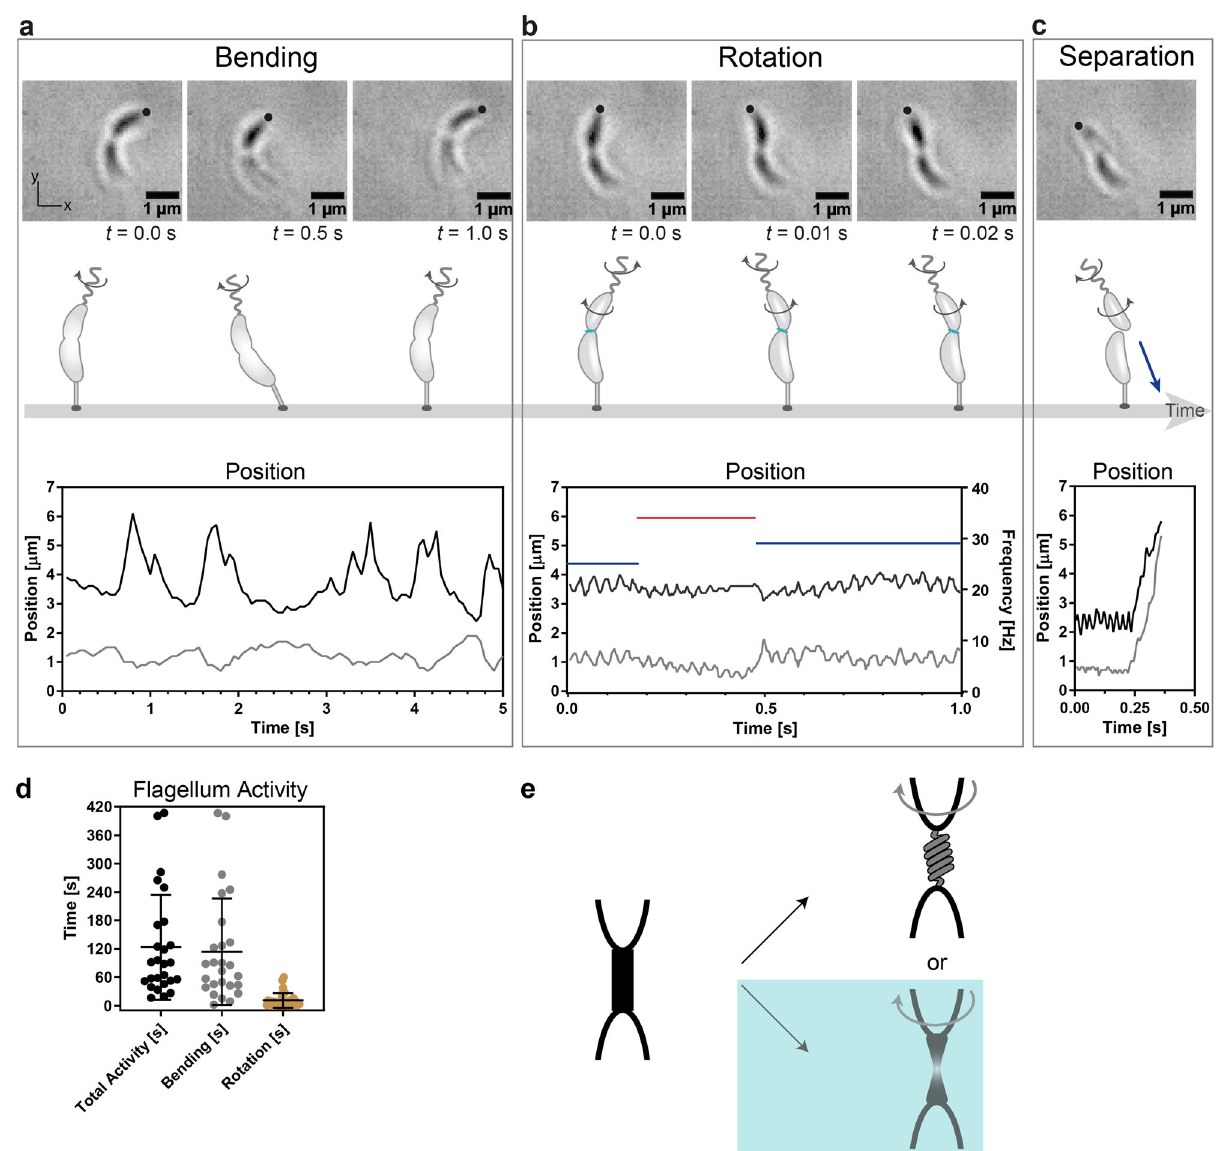
Fig. 3 Bending and rotational movements of predivisional cells attached to glass surfaces ( “ in fi nite counter mass ” ). a Micrographs and schematic representation of progression of cell separation and motion induced by the fl agellum. Bending movement: start of fl agellar rotation while the mother and the daughter side are still strongly connected. This rotation induces a bending of the predivisional cell. The strong displacements can be observed by tracking the x - and y -positions of the fl agellated pole (black: x -direction, gray: y -direction). b Rotation movement: Flagellar rotation continues and the septum connecting mother and daughter side is softened. The rotation of the fl agellum causes a counterrotation of the daughter cell while it is still connected to the mother cell. The oscillating displacements can be observed by tracking the x - and y -positions of the fl agellated pole (black: x -direction, gray: y -direction). Rotation frequencies of freely rotating predivisional daughter cells of 25 – 35 Hz can be determined as well as switching of the rotation direction can be observed (blue: CCW rotation of cell body, red: CW rotation). c When cell separation completed, the swarmer cell is released from the stalked cell and is propelled by the rotating fl agellum, which can be seen in the trajectories of the fl agellated pole, now a swarmer cell – rotating motion followed by a ballistic motion (black: x -direction, gray: y -direction). d Duration of the overall activity from fi rst observed bending movement until cell separation ( N = 26), duration of the bending stage ( N = 26), and of the rotation stage ( N = 29). Error bars represent ± SD. e Schematic representation of two possible scenarios describing the softening of the septum connecting the two sides of a predivisional cell and the free rotation of the daughter side: over-twisting of the connection, which could not be observed, or the formation of a liquid-like bridge between the two sides (turquoise box), which is in agreement with our